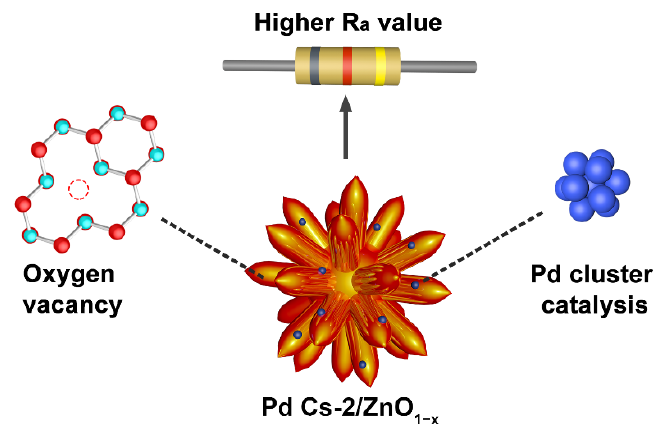
Figure 14. Illustration of the gas-sensing mechanism.